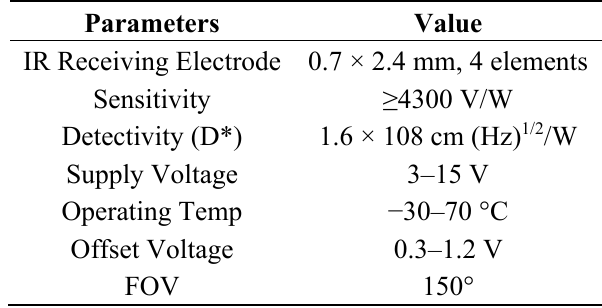
Table 1. The Parameters of D205B Pyroelectric Infrared Sensor.